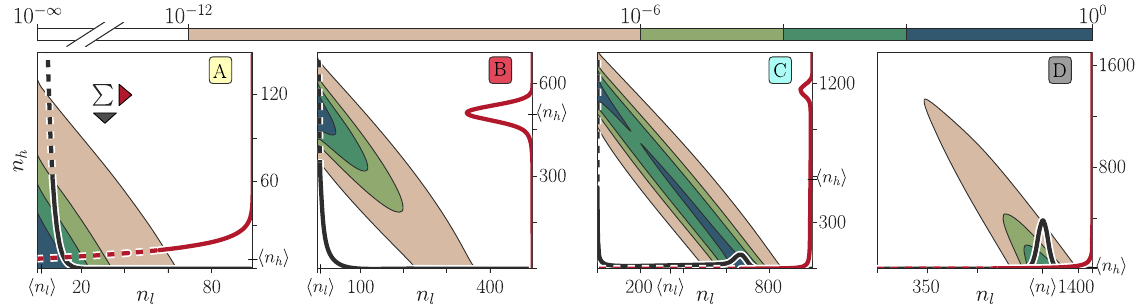
4. Two-mode photon statistics obtained from the reduced master equation (see Appendix B) with single-mode statistics for mode l at the bottom (black) and mode h at the right (red) axis, for injection currents I ¼ 12 . 5 μ A, 27 . 4 μ A, 41 . 7 μ A, 60 . 0 μ A (phases A, B, C, D). These pump rates are also indicated by arrows in Fig. 2(b). The labels h ˆ n each mode. For a better comparison, the single-mode statistics are depicted up to 0.025% by solid lines, while the remaining part is shown by dashed lines. Note that the plotted range of photon numbers increases from left to